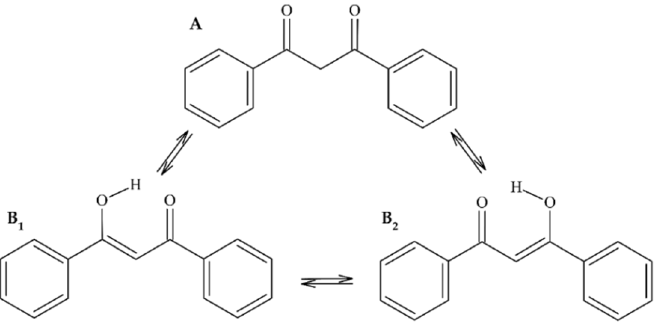
Figure 1 . Chemical structure of compound 1. The structures represent the tautomeric keto ( A ) and enol ( B 1 , B 2 ) forms in equilibrium. enol ( B 1 , B 2 ) forms in